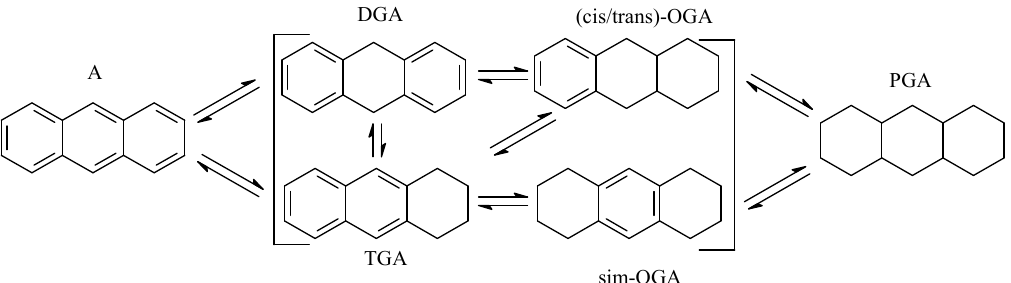
Figure 8. Hydrogenation of anthracene.